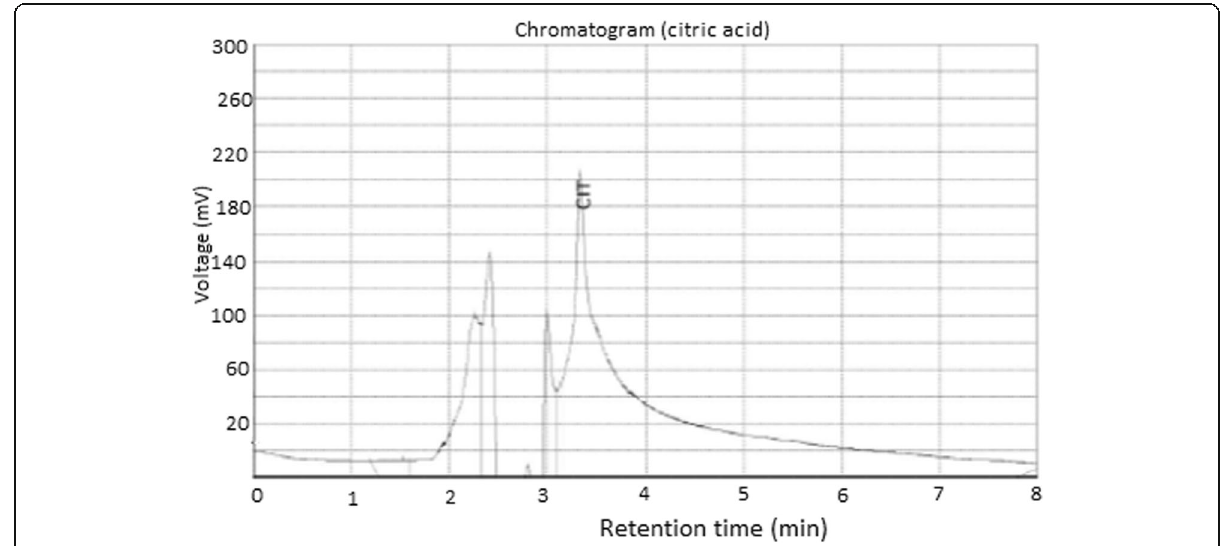
Fig. 7 HPLC chromatogram of citric acid produced by A. niger LCFS 5 in the cashew apple juice medium